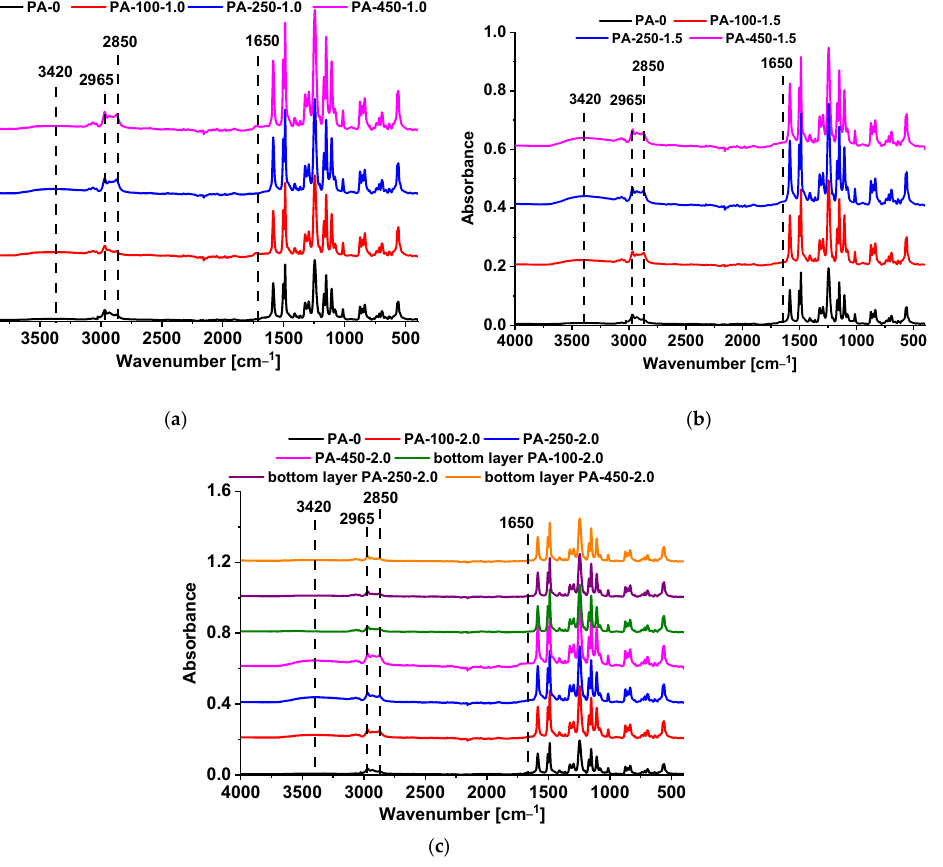
Figure 1. FTIR spectra of the skin and underside layers of PSF membranes obtained using PAA of different molecular weights as an additive to the coagulation medium. PAA concentration, wt.%: ( a ) 1.0; ( b ) 1.5; and ( c ) 2.0.